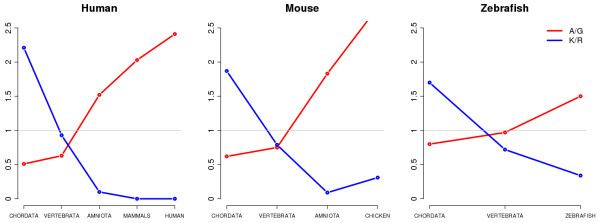
Observed versus expected number of LCRs in the different branches leading to an extant organism. Data is shown for LCRs enriched in K or R (in blue) and in A, G or AG (in red). The observed distribution of LCRs labeled in blue deviated significantly from the expected one in all three cases (Fisher’s exact test p < 10-3). The observed distribution of LCRs labeled in red deviated significantly from the expected one for human LCRs (Fisher’s exact test p < 10-3).